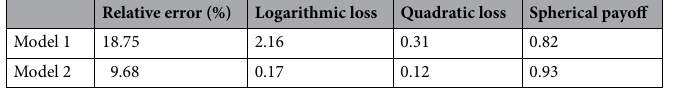
Table 3. Overall accuracy measures of the models.